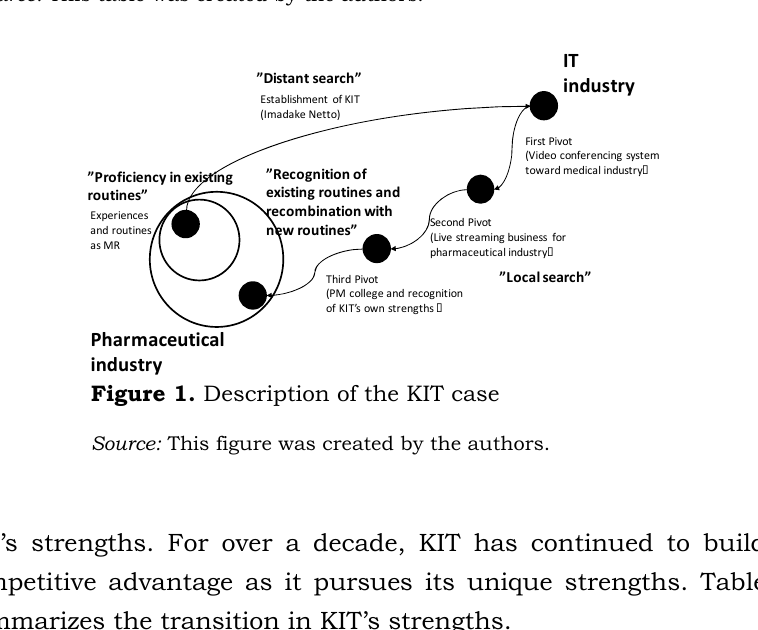
Source: This table was created by the authors.